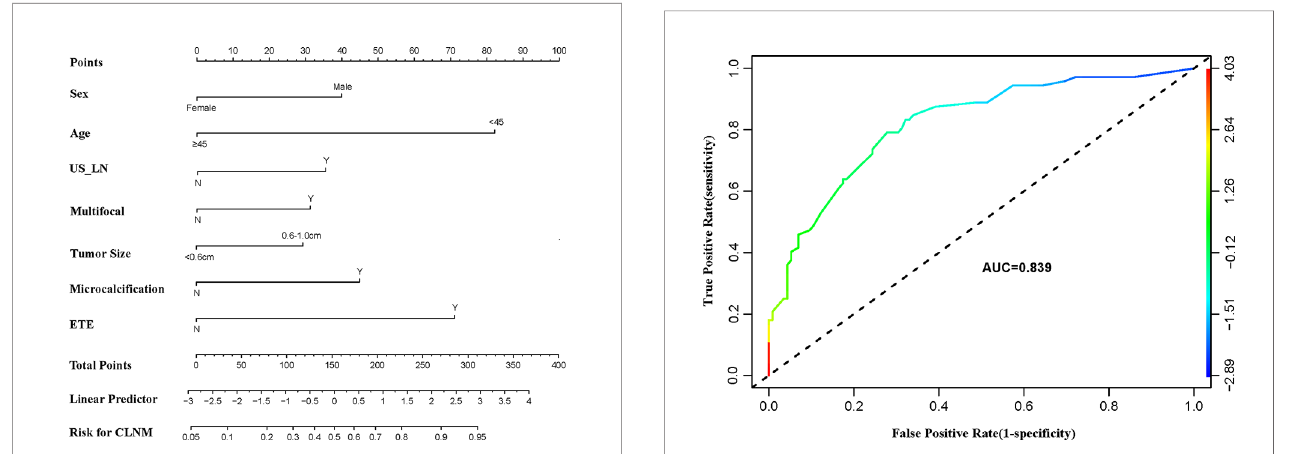
FIGURE 2 | Nomogram for predicting CLNM in PTMC patients.